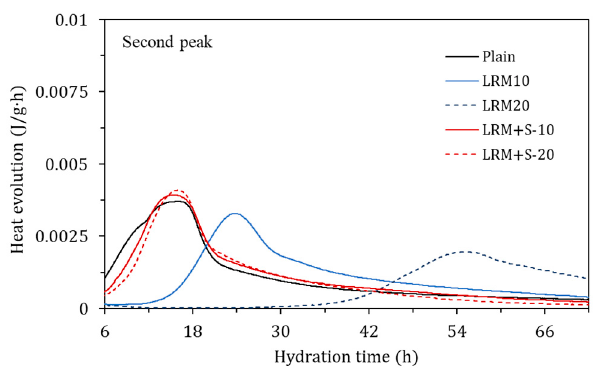
Figure 3. Heat evolution rates of the various cement paste samples.